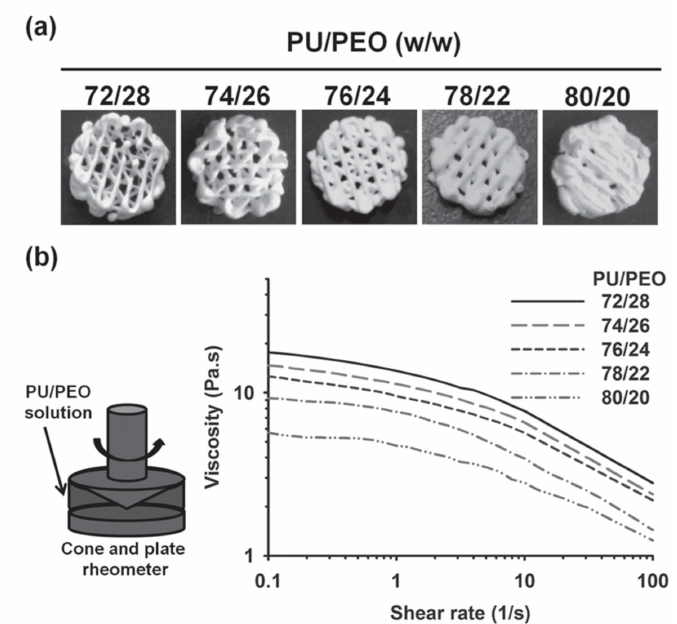
Figure 9. Fabrication of 3D scaffolds with various PU/PEO dispersions and rheological properties of the dispersions. ( a ) The gross appearance of the scaffolds fabricated with various PU/PEO ratios. ( b ) The viscosity of various PU/PEO dispersions in the shear rate range between 0.1 and 100 Hz. Reprinted from [127] with permission from